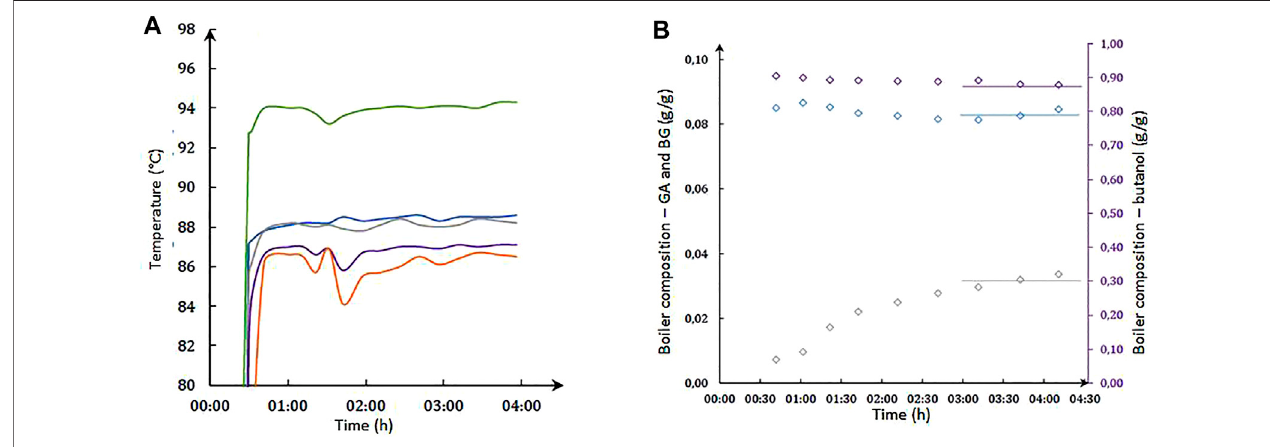
FIGURE 9 | Steady-state establishment with feed of 0.5 kg h − 1 , p = 380 mbar, and R = 1. (A) Temperature in column T 1 (boiler) ( ), T 2 (column bottom) ( ), T 3 (mid-column) ( ), T 4 (column top) ( ), and T 5 (condenser) ( ) versus time; (B) boiler composition in BA, GB, and butanol versus